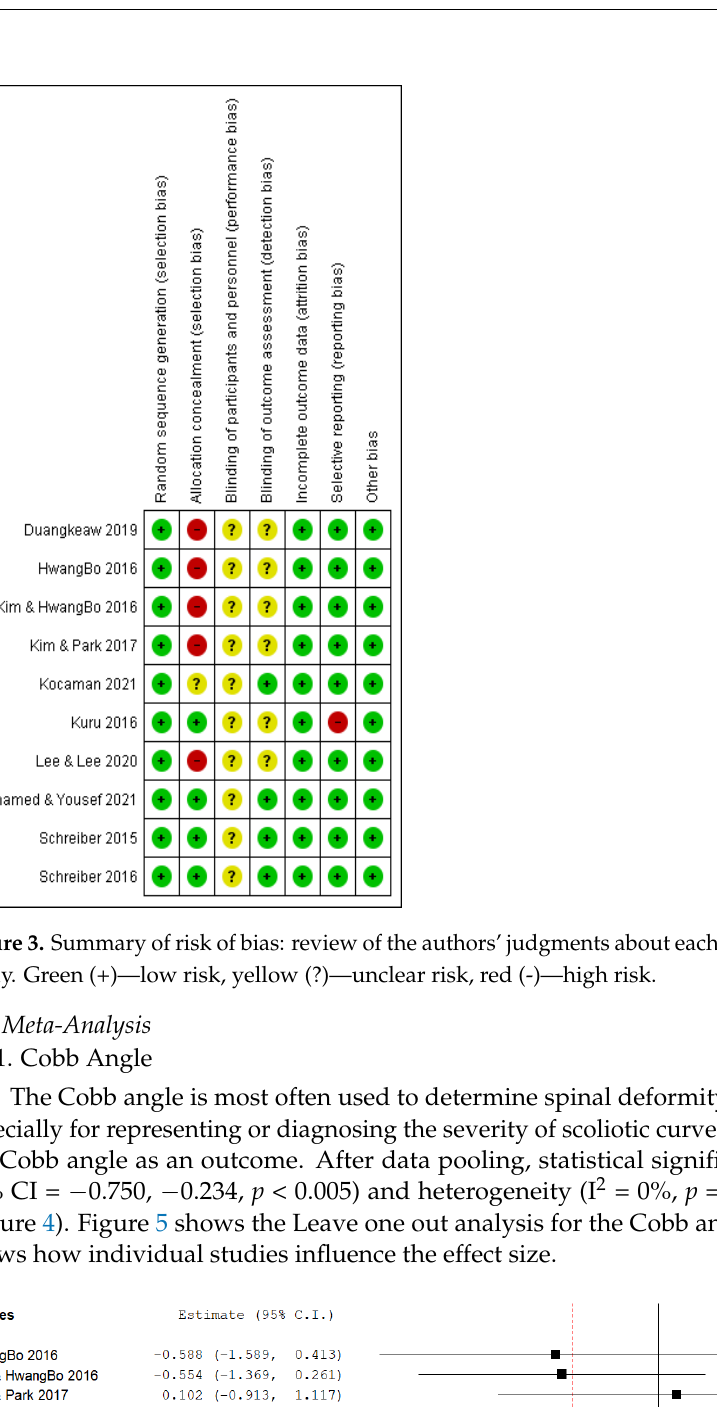
Figure 2. Risk of bias graph: authors’ assessment of each item expressed as a percentage for all in ‐ cluded studies.